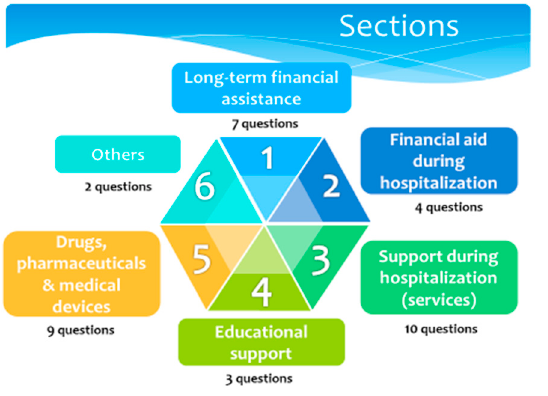
Figure 1. Structure of the Social Resource Survey. General content of the six sections and number of